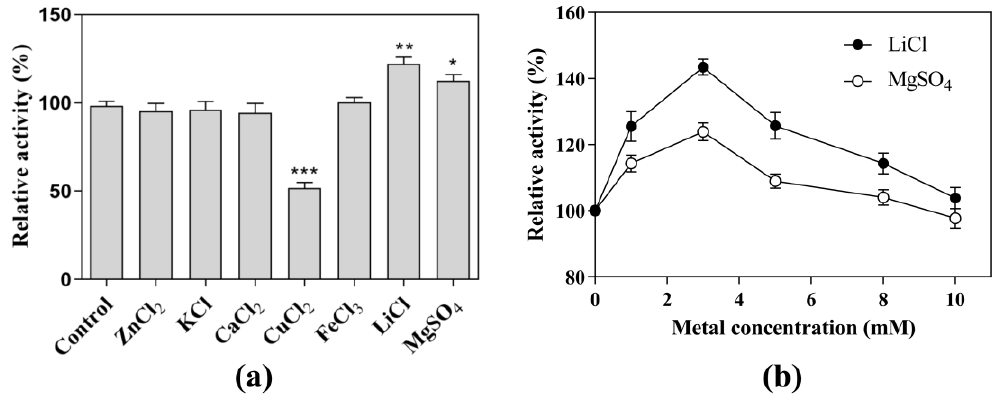
Figure 3. Effects of metal on the CK-producing activity. Effects of ( a ) metal ions and ( b ) LiCl and MgSO 4 concentrations on CK-producing activity. The reactions for the effects of metal ion, LiCl, and MgSO 4 concentrations were performed at 80 ◦ C in acetate buffer (50 mM and pH 6.0) containing 10 mg/mL SS-bgly, 5 mg/mL ginsenoside substrate, and 5 mM of CuCl 2 , FeCl 3 , MgSO 4 , CaCl 2 , KCl, and LiCl, and 0–10 mM LiCl or MgSO 4 for 4 h. Experiments were performed in triplicate. The data represent the means of replicates and the error bars represent standard deviations. * p < 0.05; ** p < 0.001; *** p <